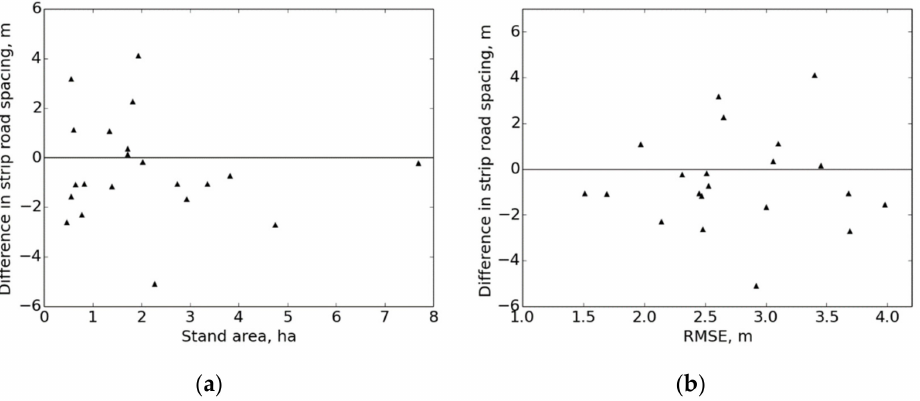
Figure 10. The differences between the average strip road spacings of the computed and reference strip road networks. ( a ) Difference as a function of the stand area.; ( b ) difference as a function of the RMSE of the strip road